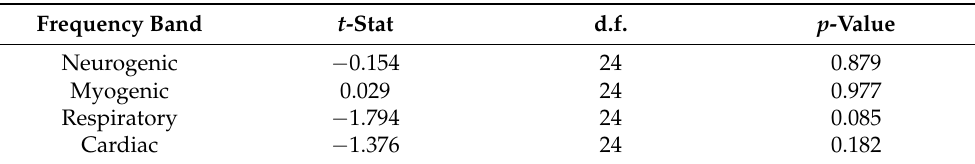
Table 1. The t -test results concerning the differences between AD and HCs for each PSD at the different frequency bands.